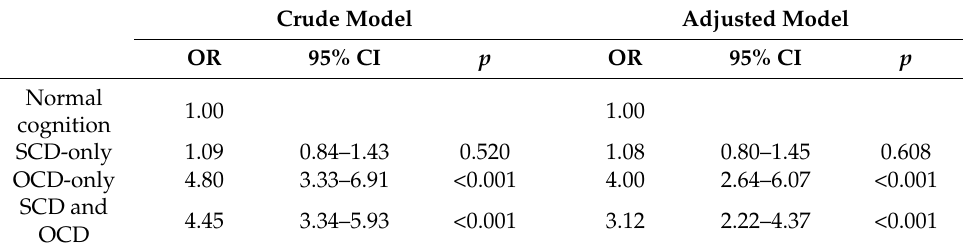
Table 3. Binomial logistic regression analysis with presence of OCD at follow-up as a dependent variable. Crude